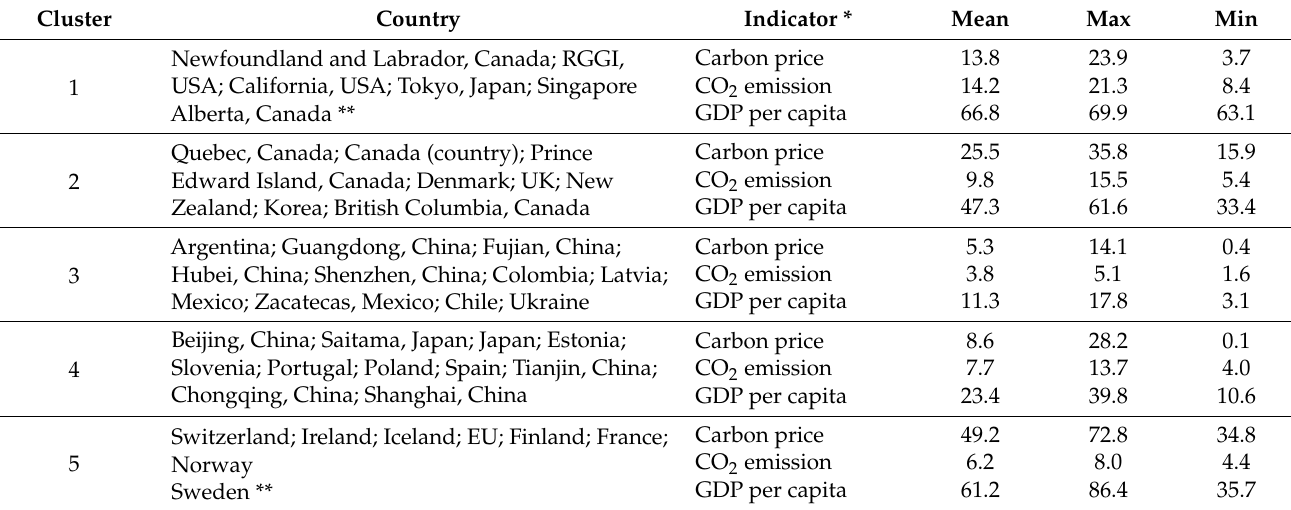
Table 3. Clustering according to the economic and environmental